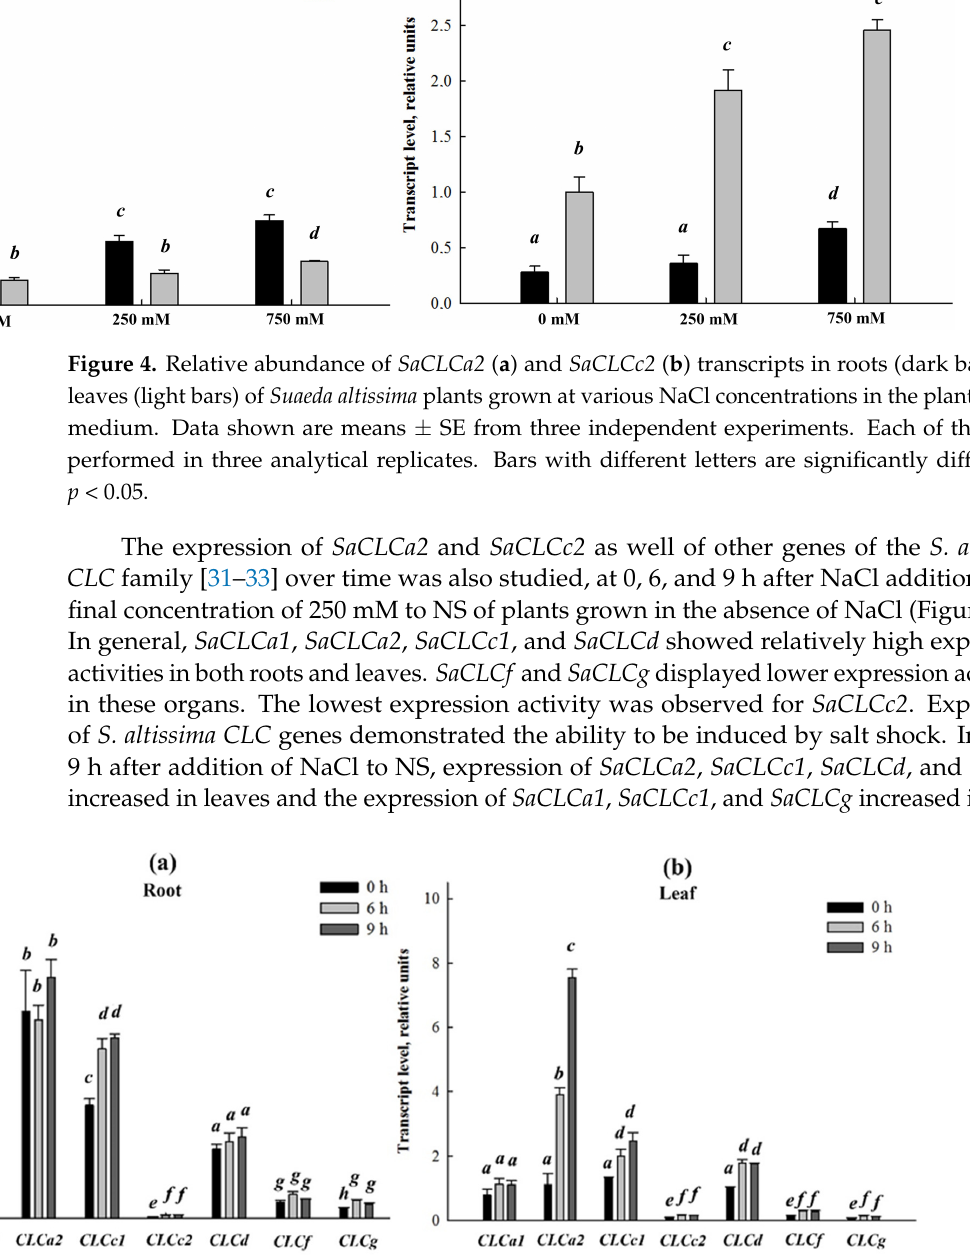
Figure 5. Relative transcript abundances of chloride channel family genes in roots ( a ) and leaves ( b ) of Suaeda altissima plants over the time course of salt stress. The plants were grown on the medium without NaCl followed by, at zero time-point, addition of NaCl at the final concentration of 250 mM. Data shown are means ± SE from three independent experiments. Each of them was performed in three analytical replicates. Bars with different letters are significantly different at p < 0.05.